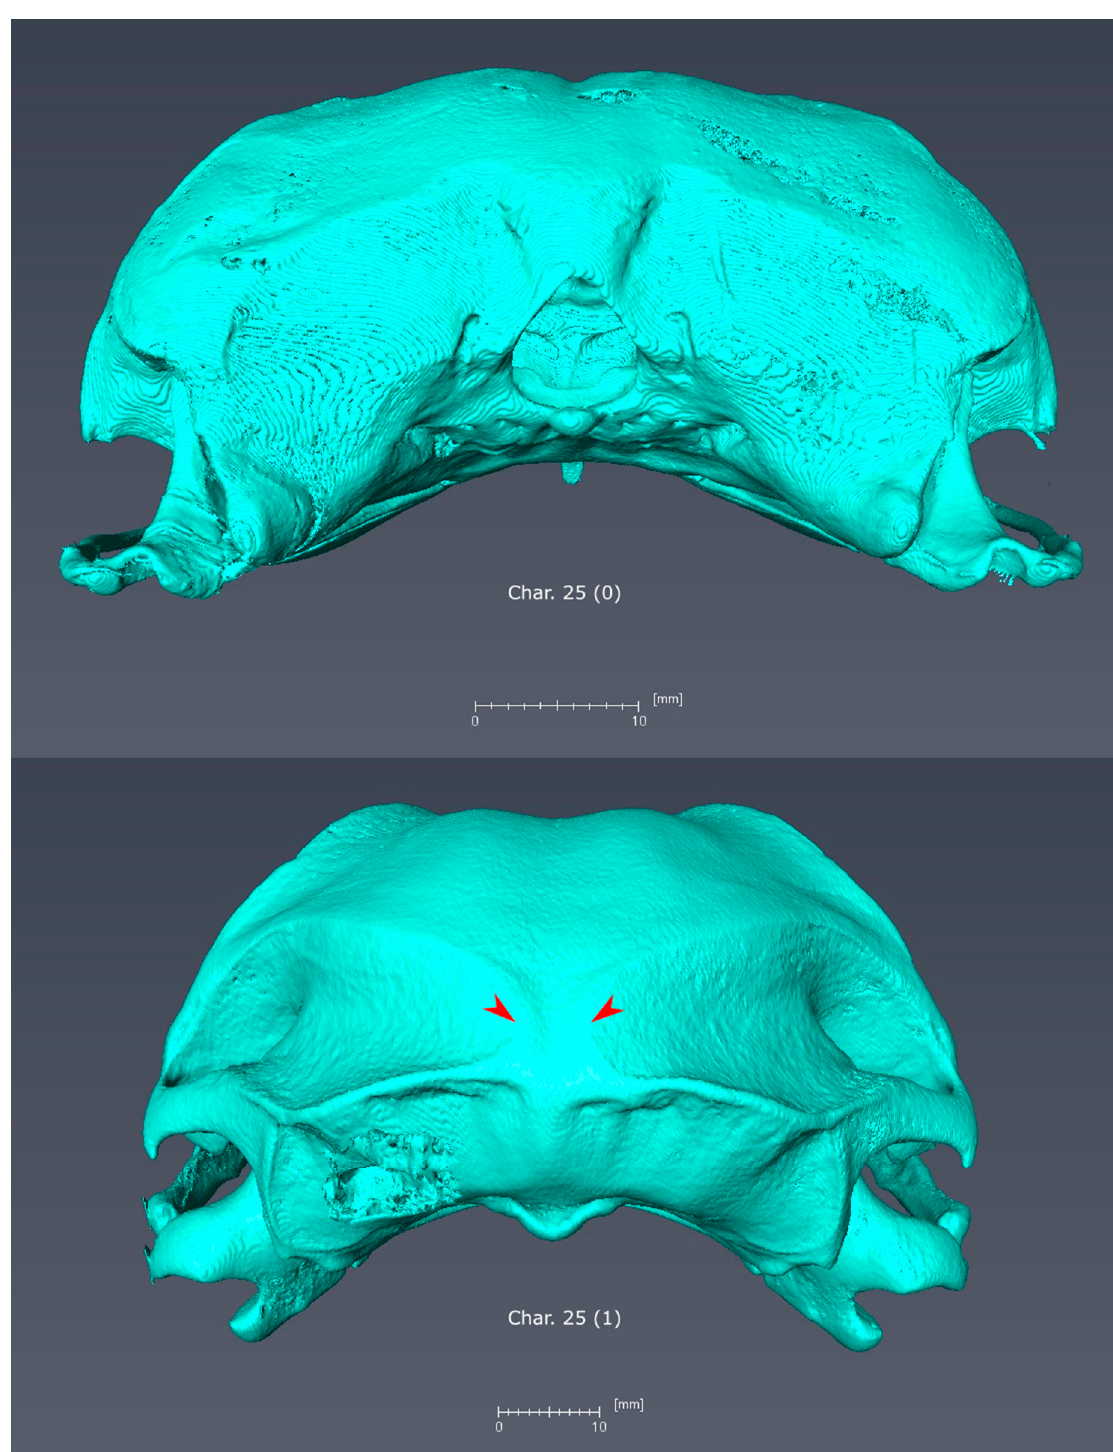
Figure A5. Crania of Nyctibius griseus (top) and Podargus strigoides (bottom) in posterior view. Nyctibius exhibits state 0 for character 25 (temporal fossae of parietals absent or far from midline), whereas Podargus exhibits state 1 (temporal fossae of parietals meeting or almost meeting at midline, optimized as a synapomorphy of Podargiformes).